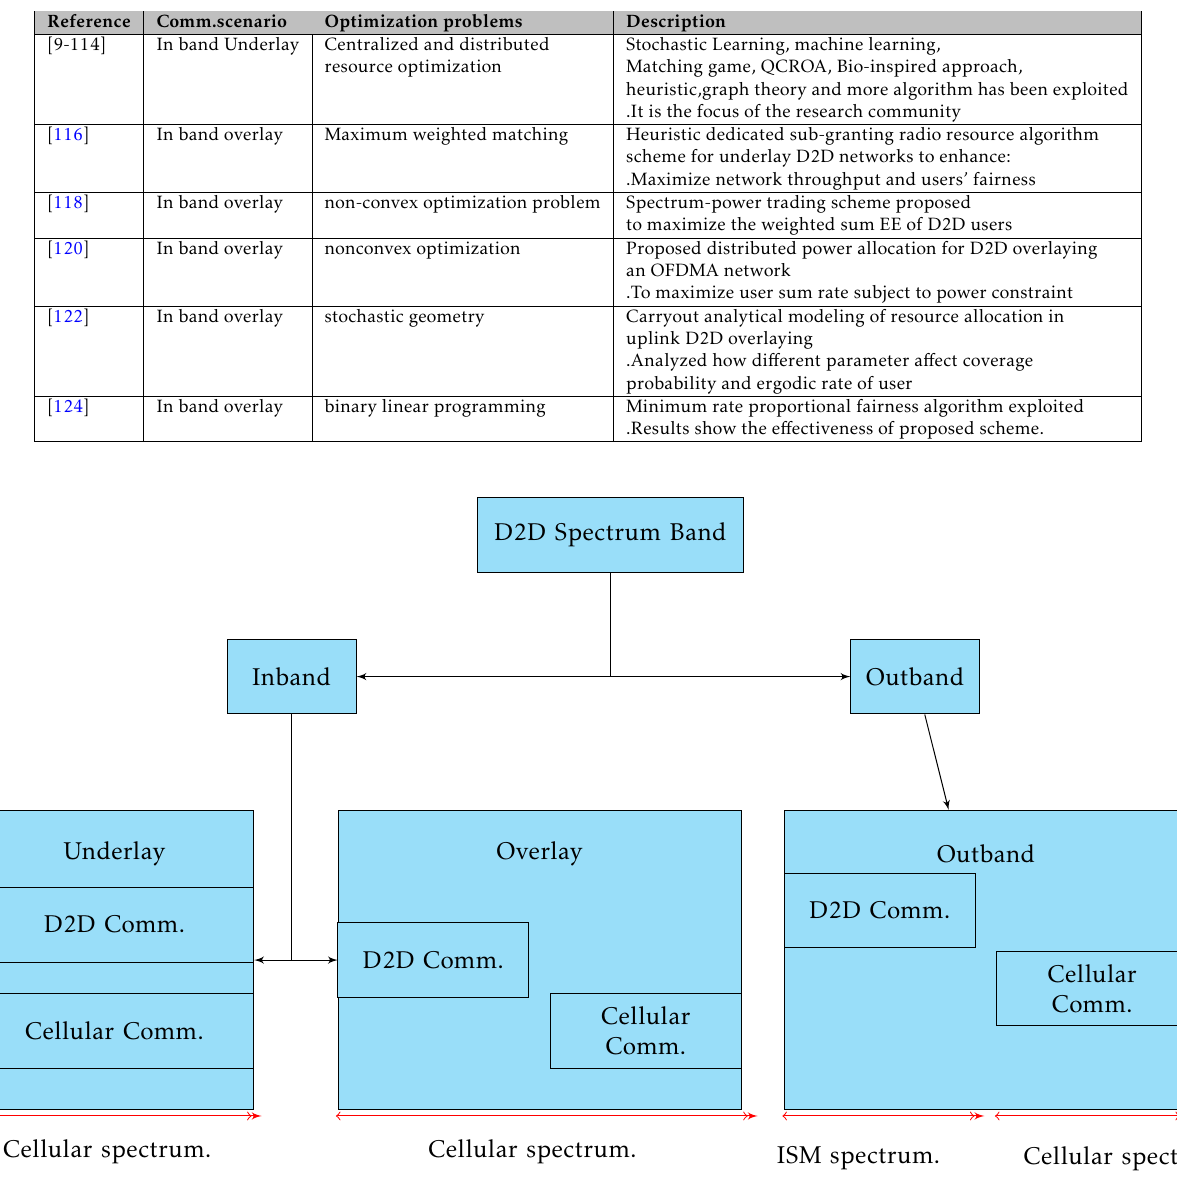
Figure 8. Schematic representation of D2D